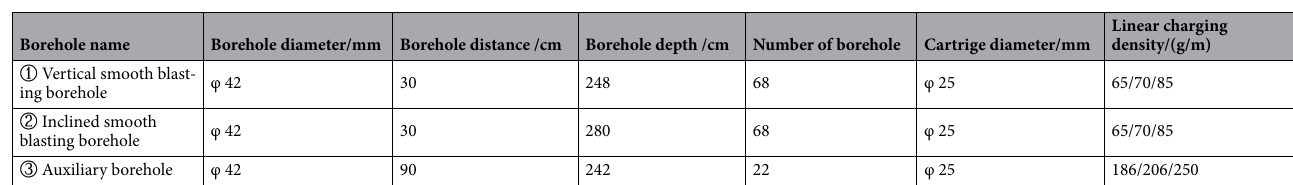
Table 1. Different borehole layouts and charging parameters.